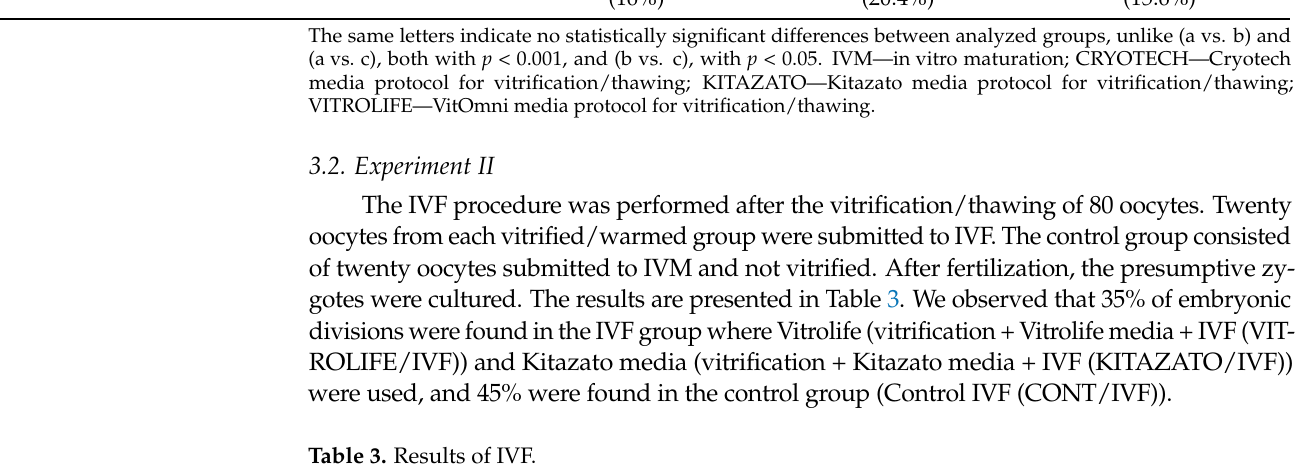
Table 3. Results of